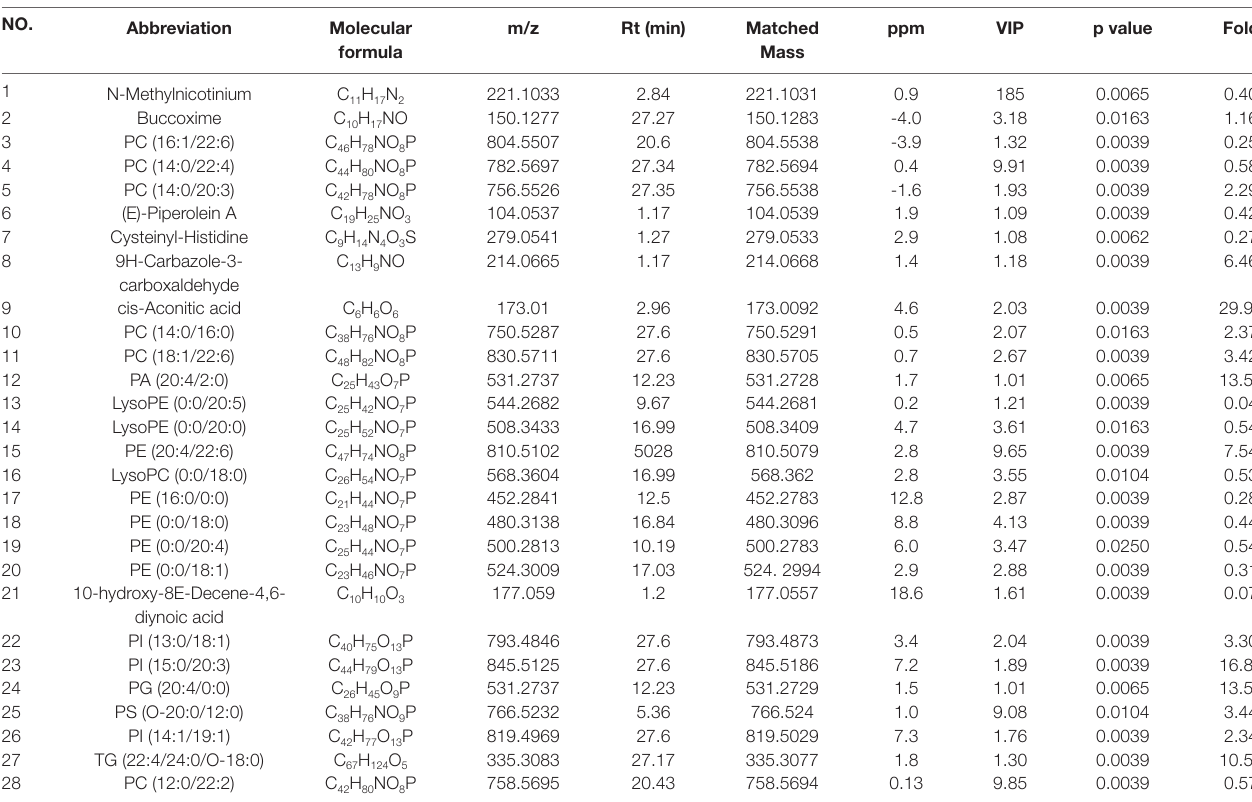
TABLE 2 | Identities of differential metabolites between control and CKD model. NO.